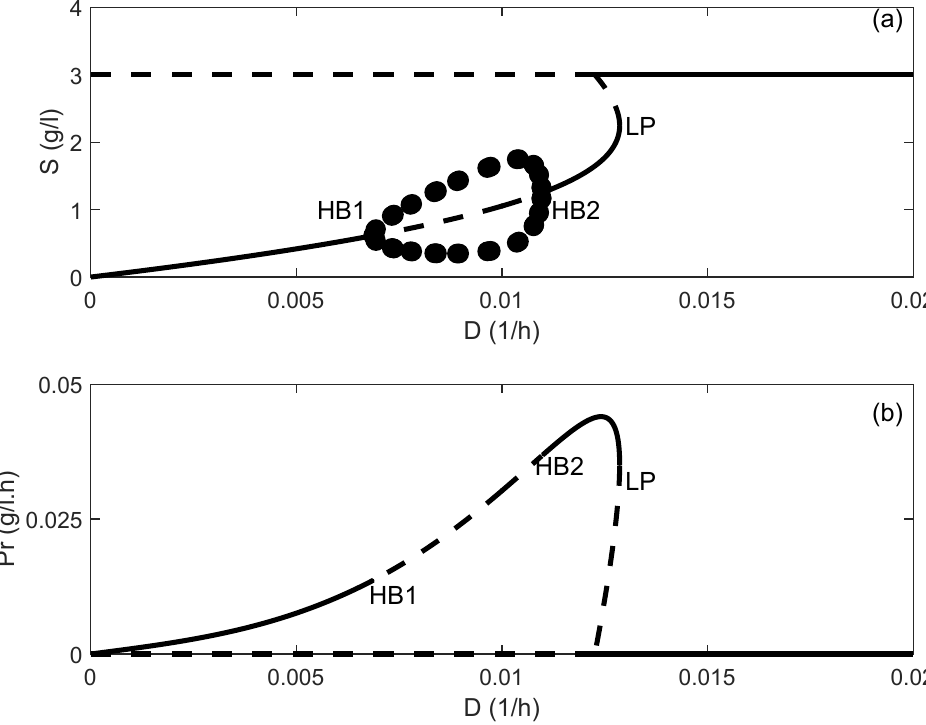
Figure 3. Model behavior for q i = 0.1 g/L and the rest of the parameters from Table 1: ( a ) continuity diagram, ( b ) productivity. Solid line (-) stable branch. Dashed line (- -) unstable branch. Filled circles, stable periodic branch. LP, static limit point. HB, Hopf